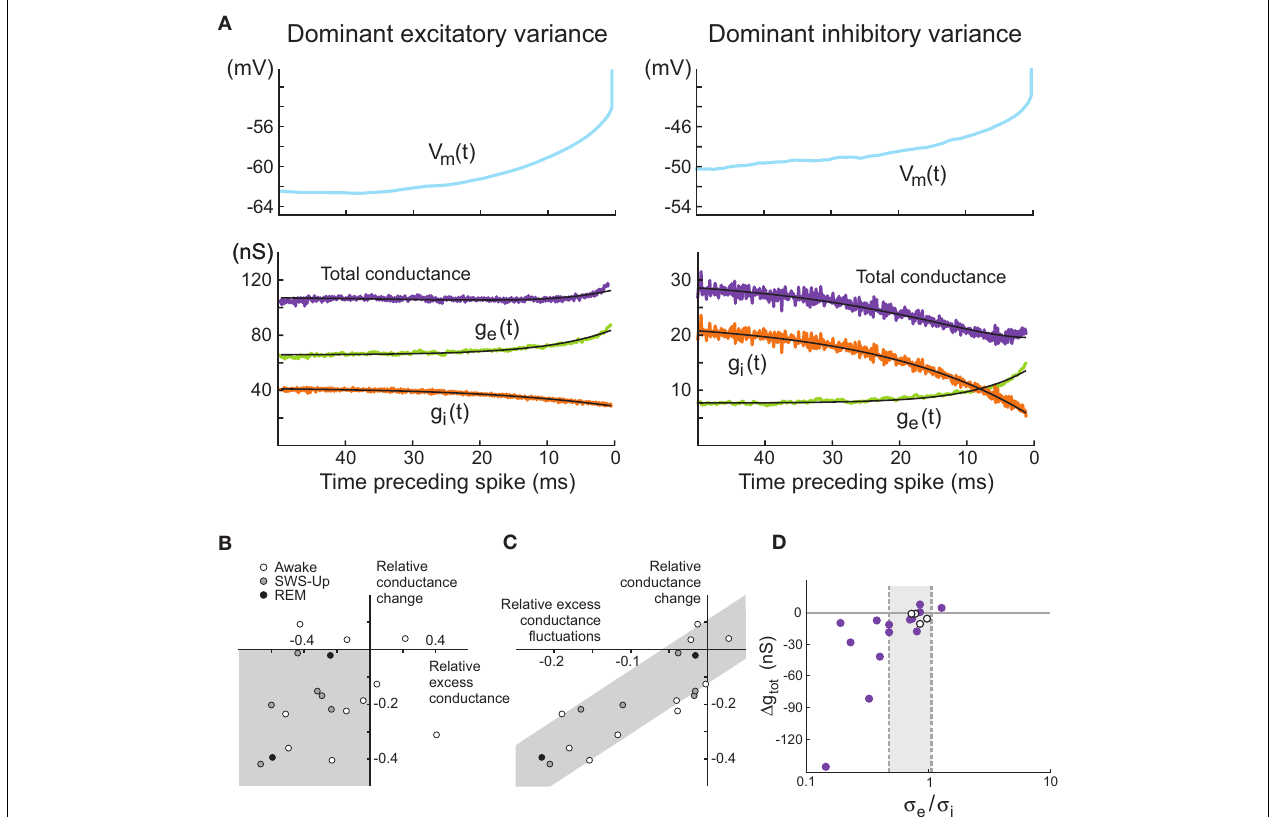
FIGURE 3 | Spike-triggered conductance analysis in vivo . (A) STA conductance analysis from intracellular recordings in awake and sleeping cats. Two example cells are shown during wakefulness, and for each, the V and the extracted conductance STAs (bottom) are shown. In the fi rst cell (left), the total conductance increases before the spike. In the second example cell (right), the total conductance decreases before the spike (black traces are exponential fi ts to the extracted STAs). This cell represents the majority of the cases. (B) Relation between total membrane conductance change before